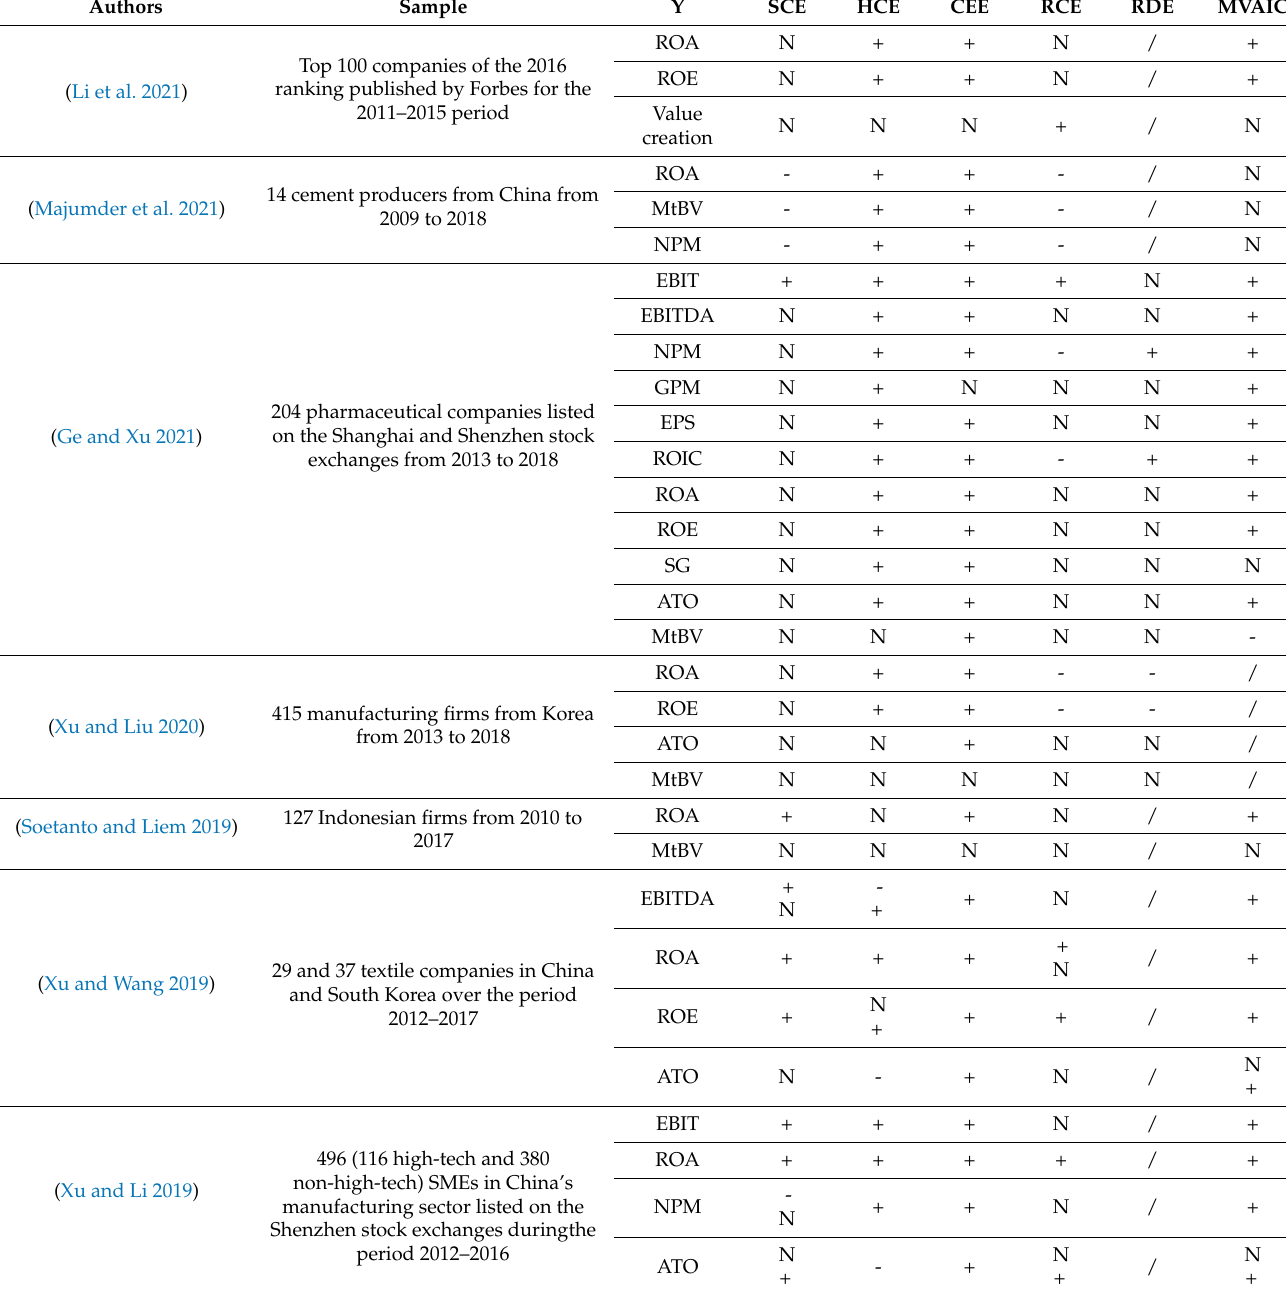
Table A2. Comparative analysis of the results of studies on the impact of intellectual capital on company performance. MVAIC